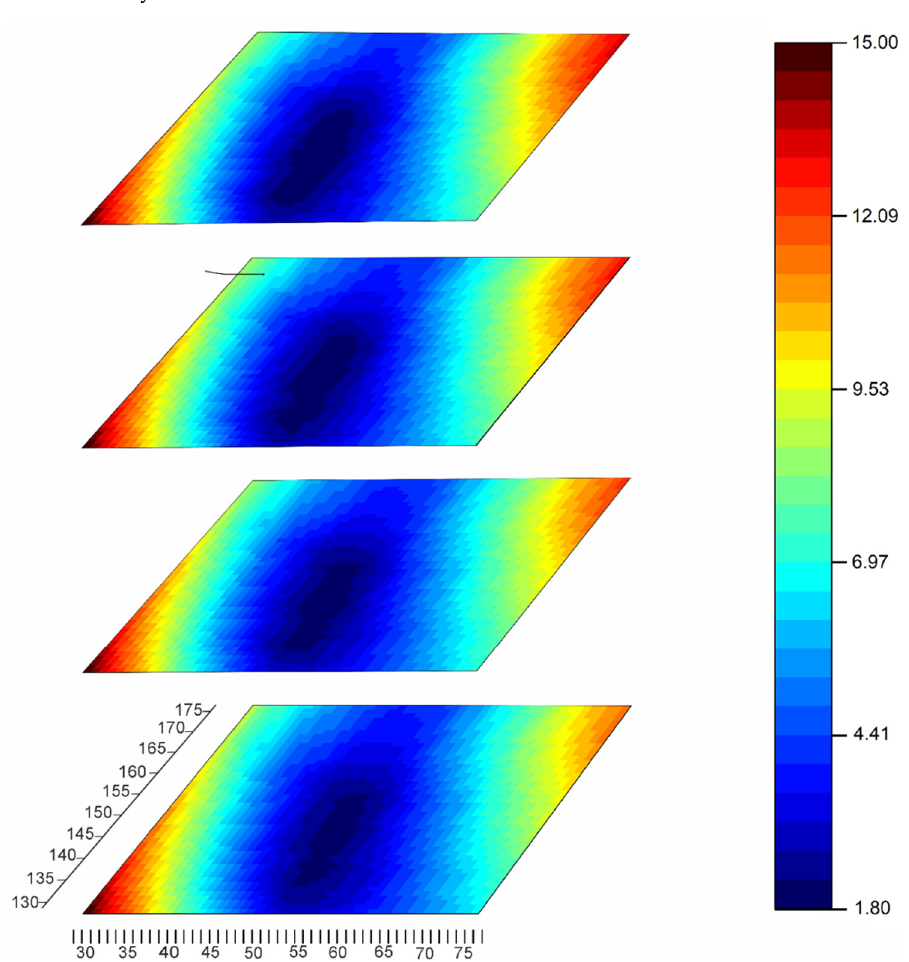
Figure 7. Variation of function d { T } ( I ) in calibration of Sensor2 on 18 April 2022, at I 1 =